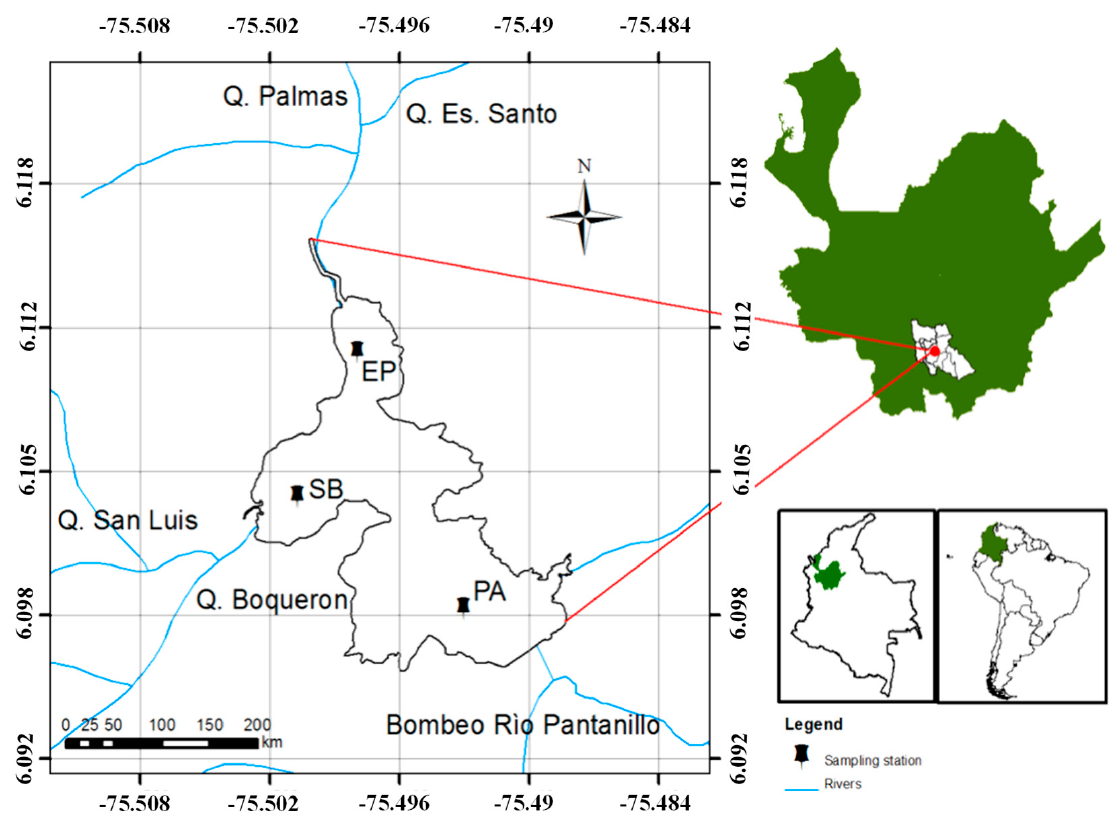
Figure 1. Location of reservoir for drinking water supply (Medellín, Colombia).